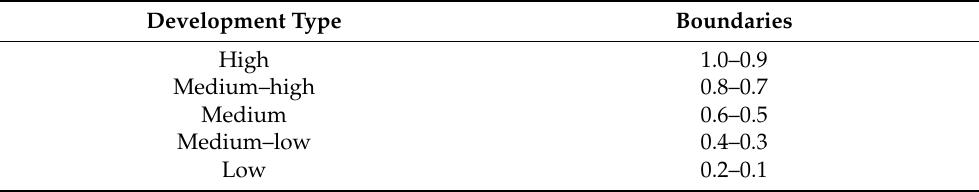
Table 1. Regional economic development aggregated and composite indicators measurement